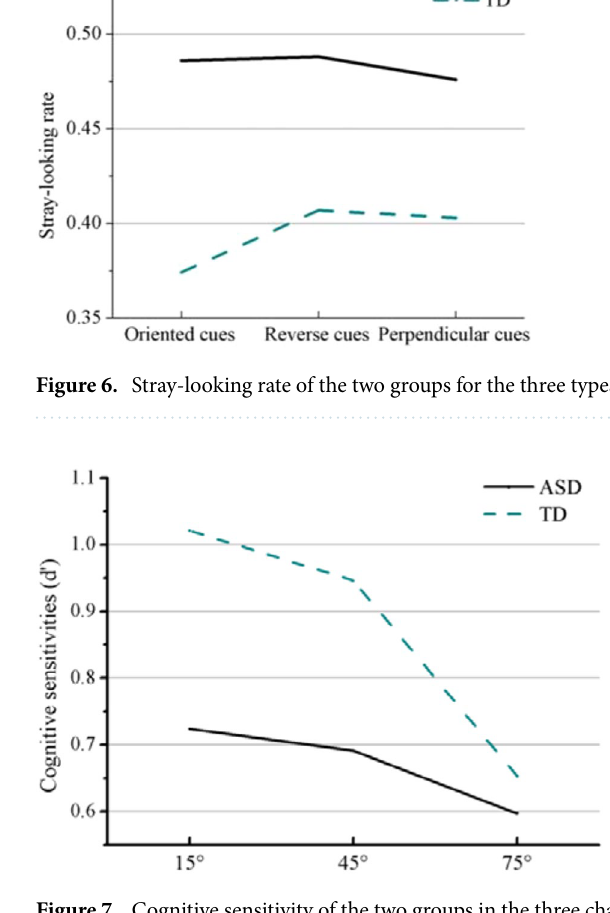
Figure 7. Cognitive sensitivity of the two groups in the three chase subtlety